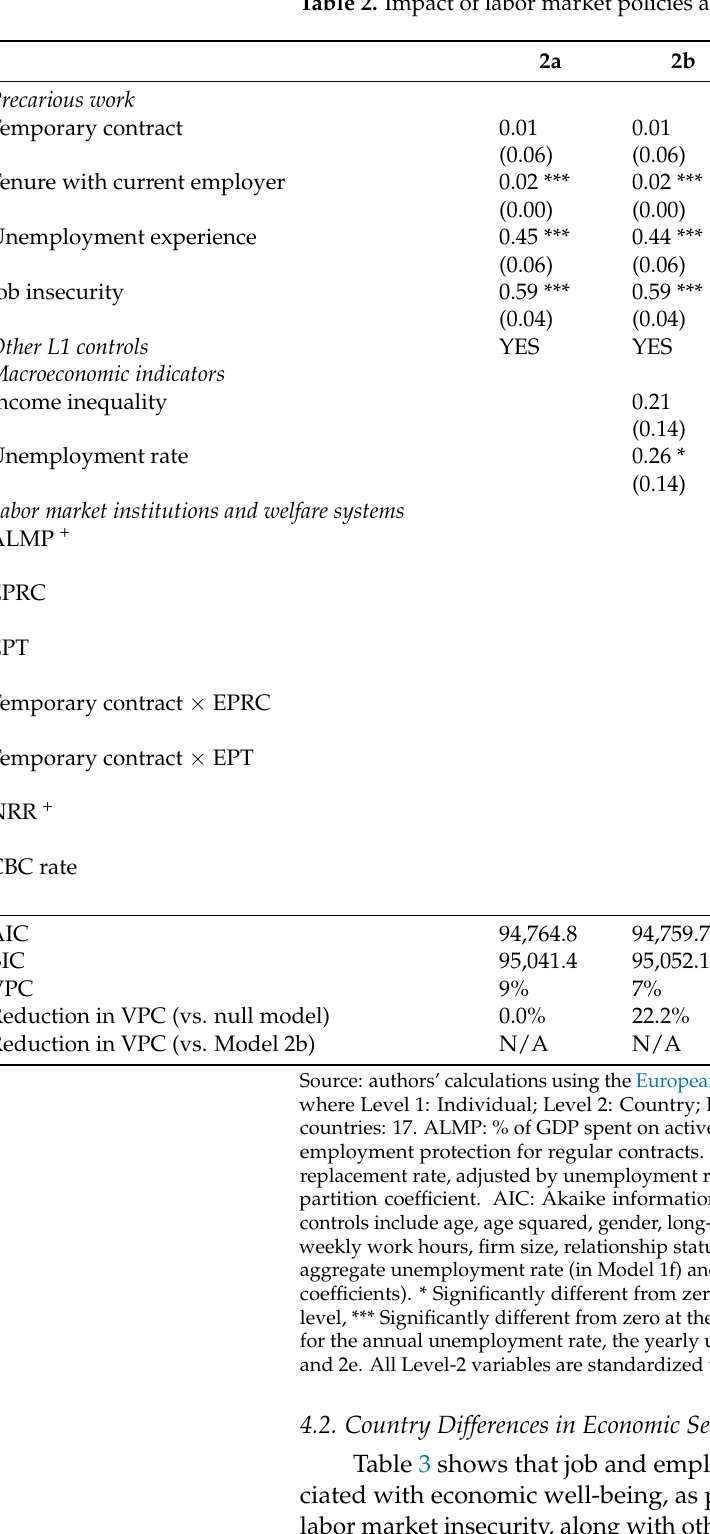
Table 2. Impact of labor market policies and welfare systems on employment